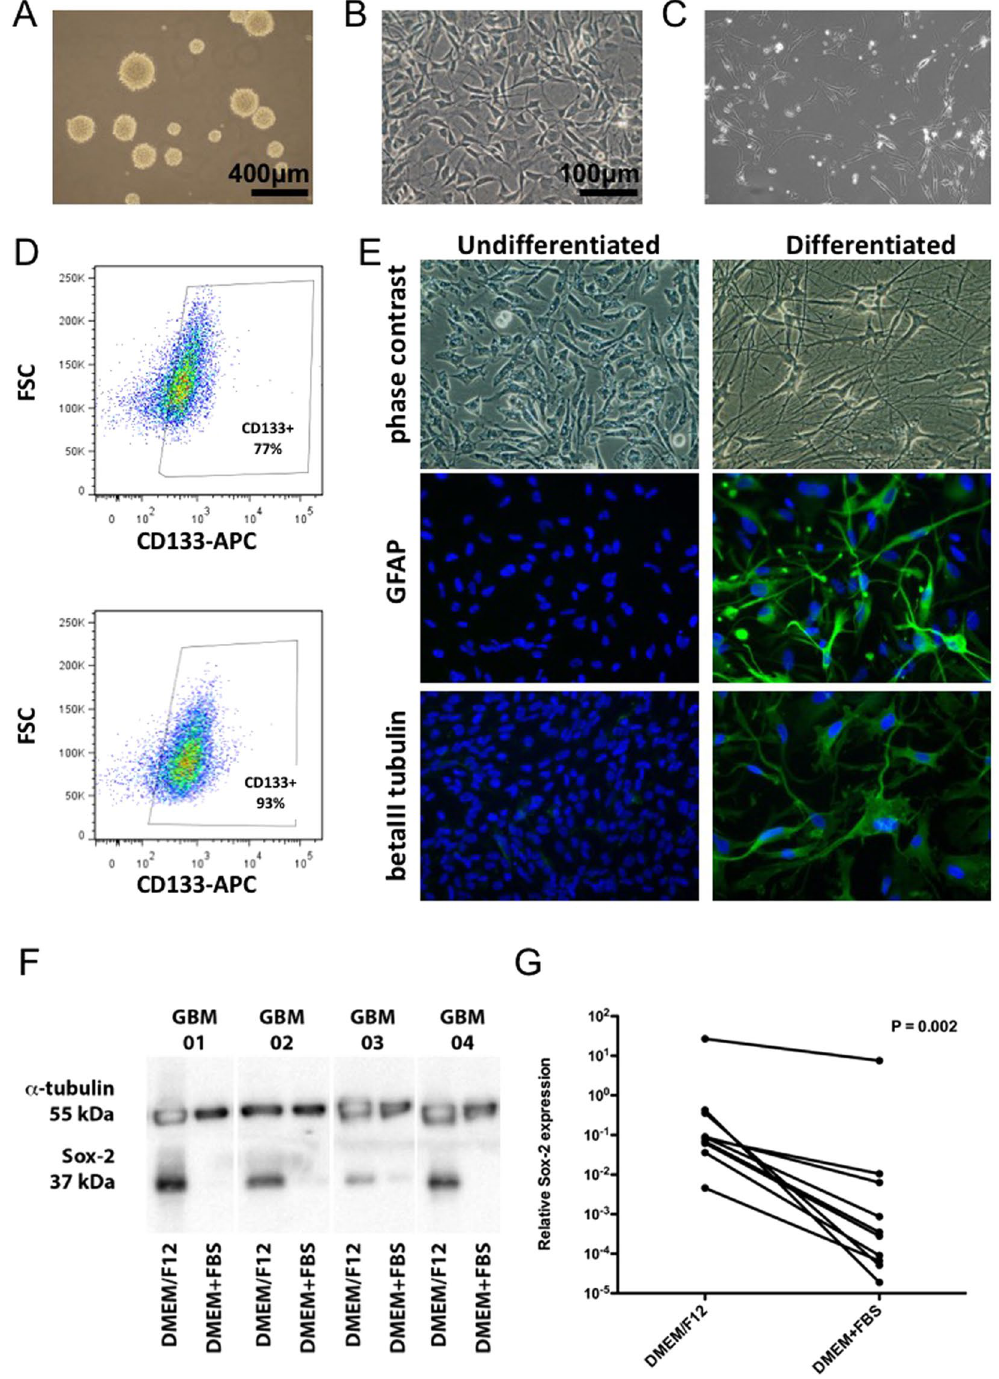
Figure 1. Characterization of the primary GBM cell cultures propagated in serum-free and serum containing media. ( A ) Cells growing in serum-free medium as gliomaspheres, ( B ) cells growing in serum-free medium on laminin, ( C ) adherent cell growing in serum containing medium, ( D ) detection of CD133 in two independent serum-free medium cultures, ( E ) differentiation of serum-free medium cultured cells induced by 10% fetal calf serum, ( F ) western blot analysis of Sox-2 and α -tubulin and ( G ) qRT-PCR of Sox-2 expression in GBM cells propagated in serum-free (DMEM/F12) and serum containing (DMEM + FBS) media. The P value signifies the statistical significance of the difference between the paired primary cell lines as assessed by the Wilcoxon paired